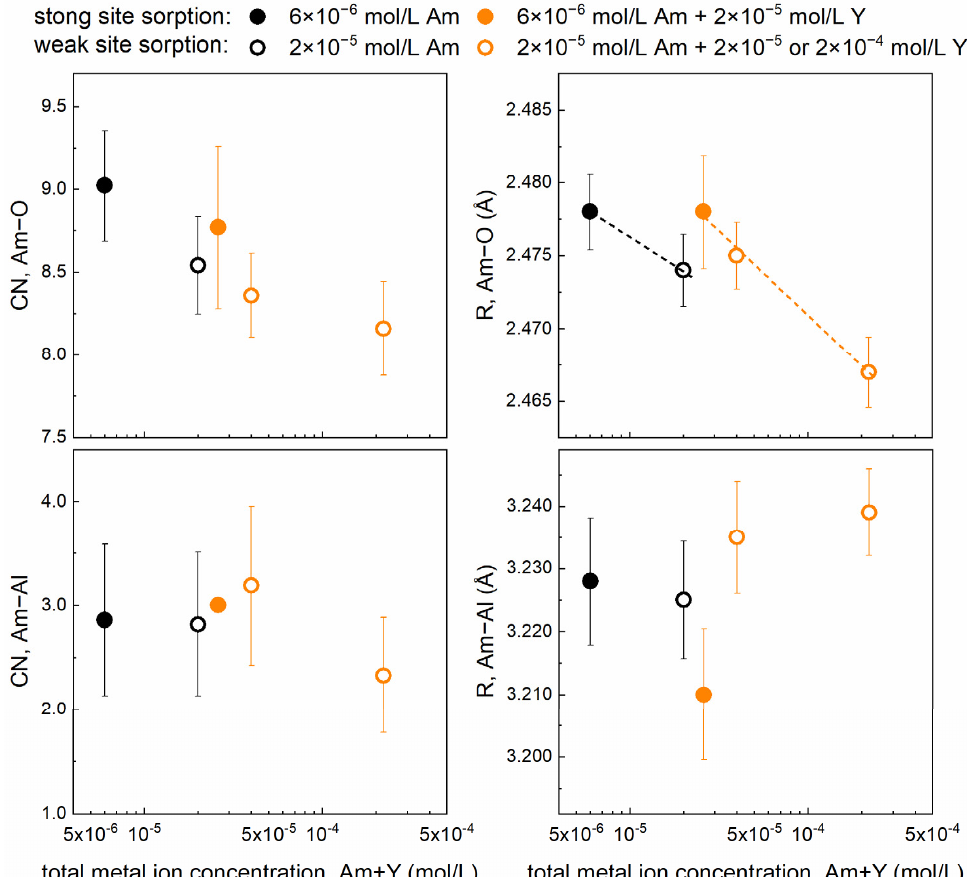
Figure 5. The derived coordination number ( left ) and bond length ( right ) for the Am–O shell ( top ) and Am–Al shell ( bottom ) as a function of overall metal ion concentration in the EXAFS samples. Black symbols (Am only), orange symbols (Am + Y). Closed and open symbols indicate samples in the strong site and weak site sorption ranges, respectively. The error bars are the calculated confidence limits (2 σ ) of the fitted parameters.